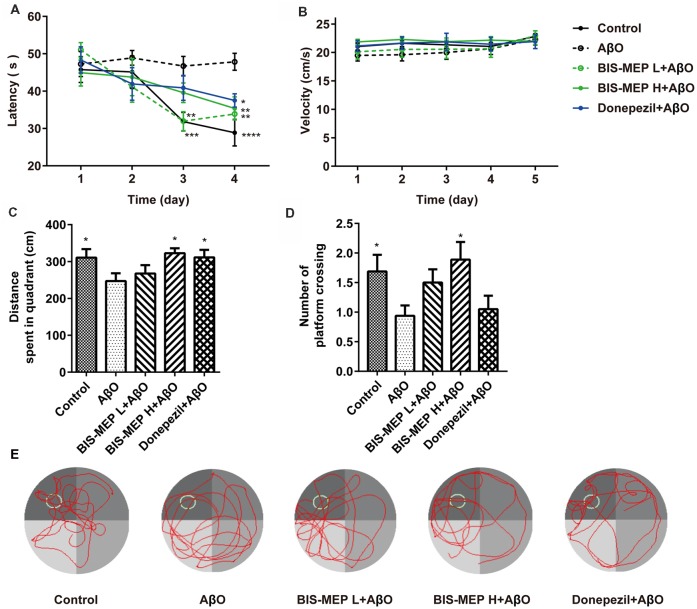
Effects of BIS-MEP on spatial reference memory in Alzheimer’s disease (AD) model mice. (A) The escape latency to locate the platform in the place navigation test. (B) The swimming velocity in the place navigation test (days 1–4) and spatial probe test (day 5). (C) The distance traveled in the platform quadrant in the spatial probe test. (D) The number of times the animals crossed the platform site in the spatial probe test. (E) Representative swimming paths of each group during the spatial probe test. Bars in the chart represent the means ± SEM for each group (n = 8–10). Significant differences between the AD model group and other groups are indicated by asterisks. *P < 0.05, **P < 0.01, ***P < 0.001, and **** P < 0.0001.